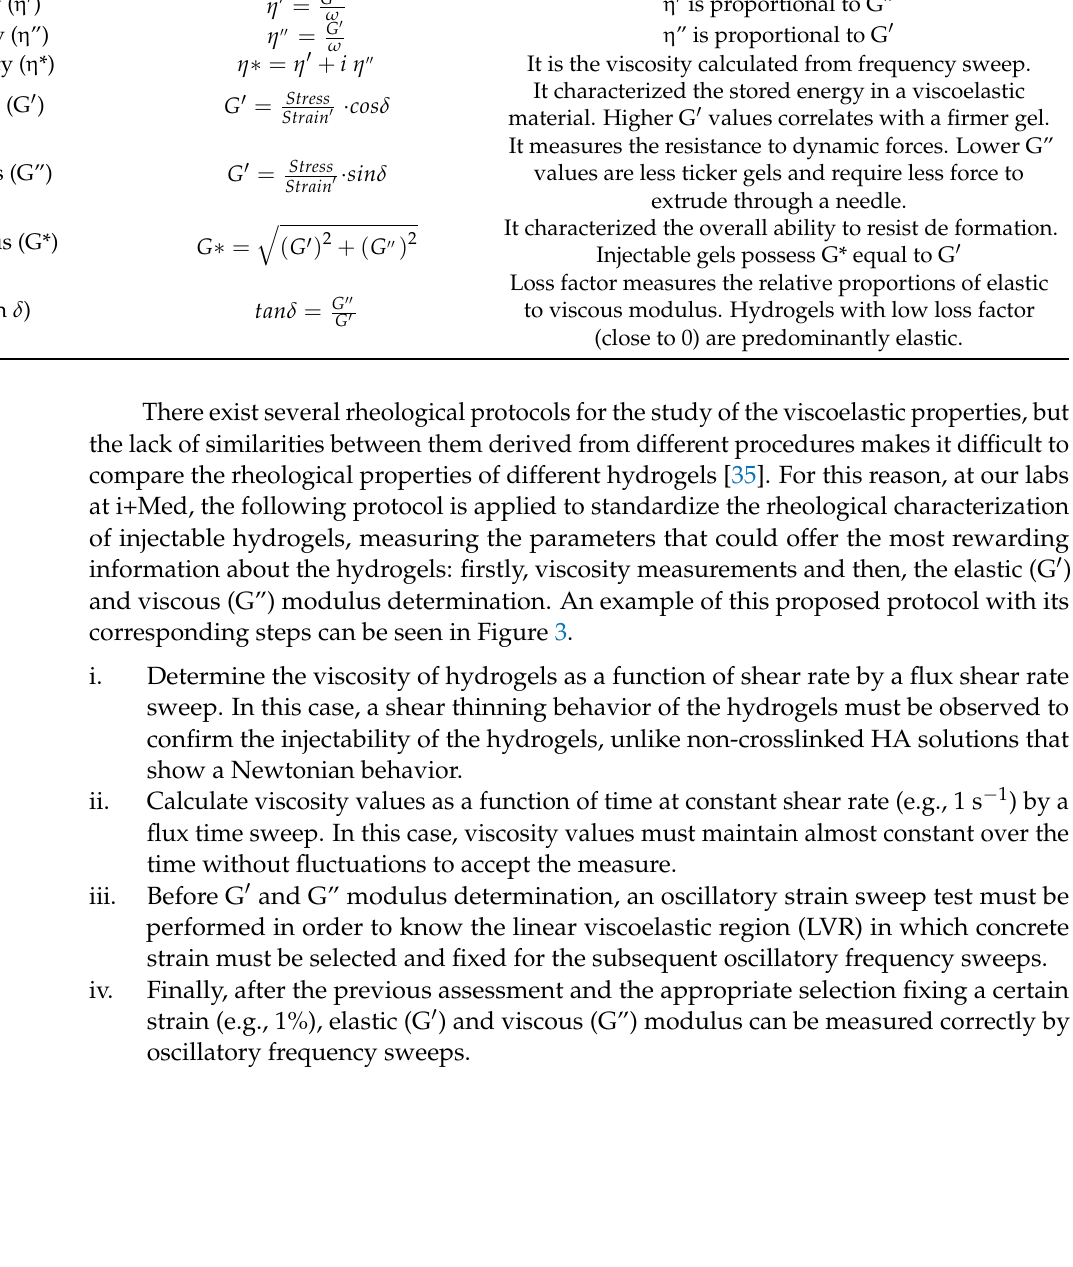
Table 1. The most relevant rheological parameters that describe the viscoelastic properties of injectable hydrogels. Parameters Formula Definition and Characteristics It is the flow characteristic of a gel and it is used to Viscosity ( η ) Strain rate η = Stress define gel